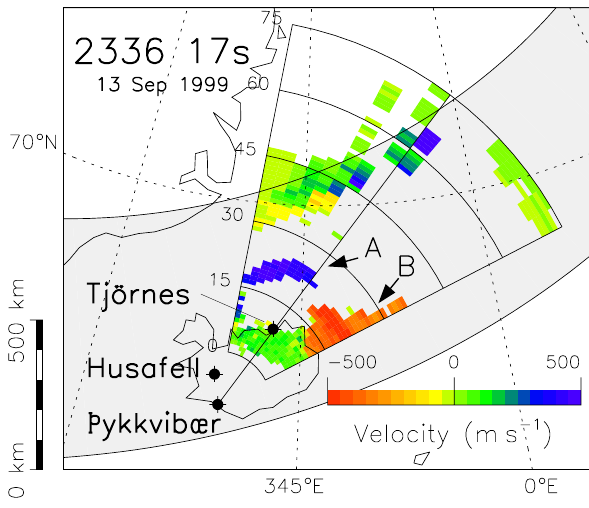
Fig. 1. A map indicating the location of the Iceland East Super- DARN radar at Þykkvibær and the Husafell and Tjörnes all-sky camera sites employed in the present study. The statistical location of the auroral oval for quiet geomagnetic conditions is also shown for context. Line-of-sight Doppler velocity determined for the radar scan starting at 2237.17 UT is presented, backscatter features A and B being indicated by